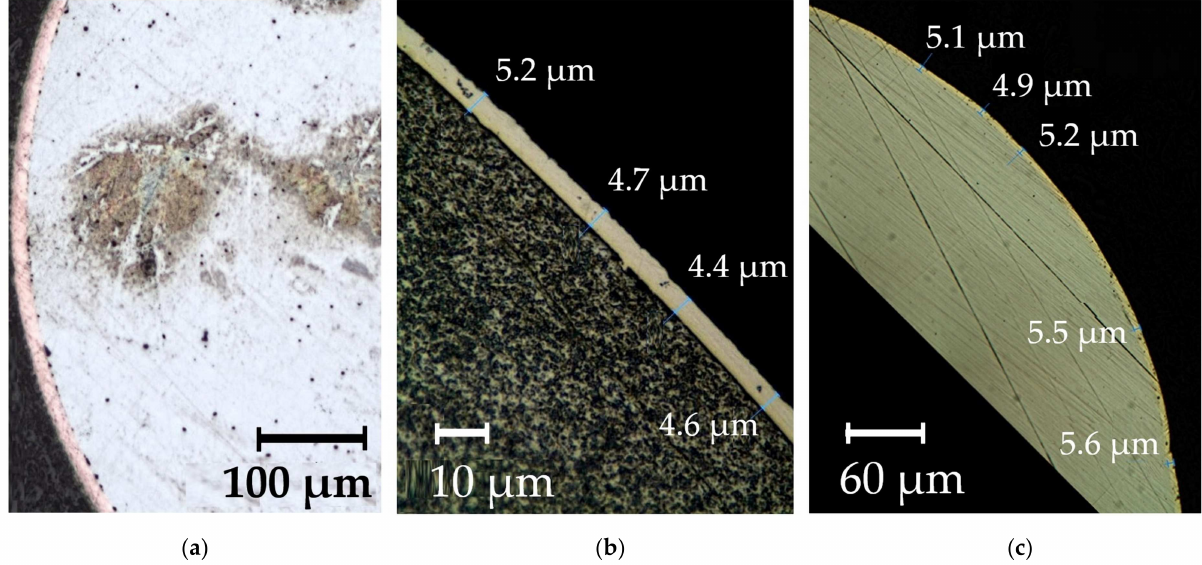
Figure 13. The optical microstructure of composite coatings on G3Si1 wire, 1.2 mm in diameter: ( a ) Cu-LaF 3 coating; ( b ) Ni-LaF 3 coating; ( c ) Ni-LaB 6